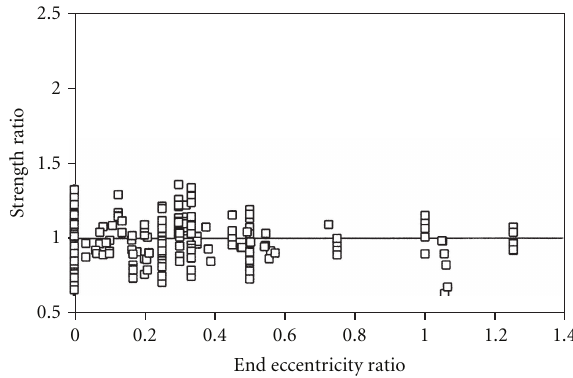
Figure 6: E ff ect of end eccentricity ratio e /h on FEM strength ratios for reinforced concrete columns ( n =